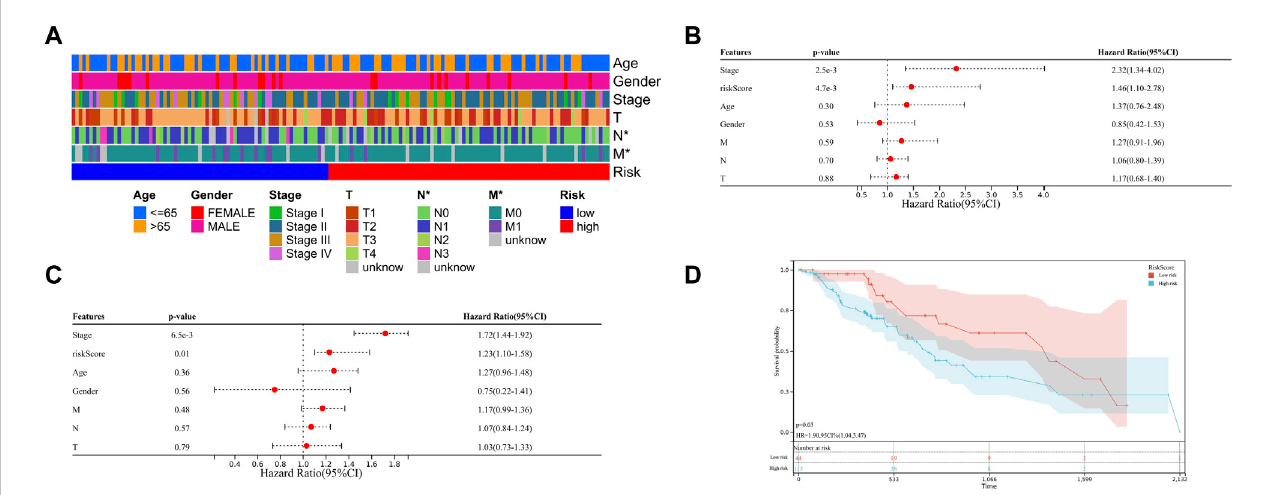
FIGURE 5 Clinicalsigni fi canceofriskgroupinginTCGA-ESCAdatabase (A) Theheatmapshowstheclinicopathologicalfeatureswerecomparedbetweenthehigh- and low-risk groups. (B) Univariate Cox analysis of the risk score and clinicopathological features. (C) Multivariate Cox analysis of the risk score and clinicopathological features to identify the independent prognostic predictors in TCGA-ESCA database. (D) Kaplan-Meier analysis for patients of TCGA-ESCA database in high- and low-risk group. Data are shown as the means ± SD. * p < 0.05. ESCA, esophageal squamous cell carcinoma; TCGA, The Cancer Genome Atlas; HNRNPC, RNA-binding protein, is a member of the heterogeneous ribonucleoproteins C; YTHDF1, YTH N6-methyladenosine RNA-binding protein